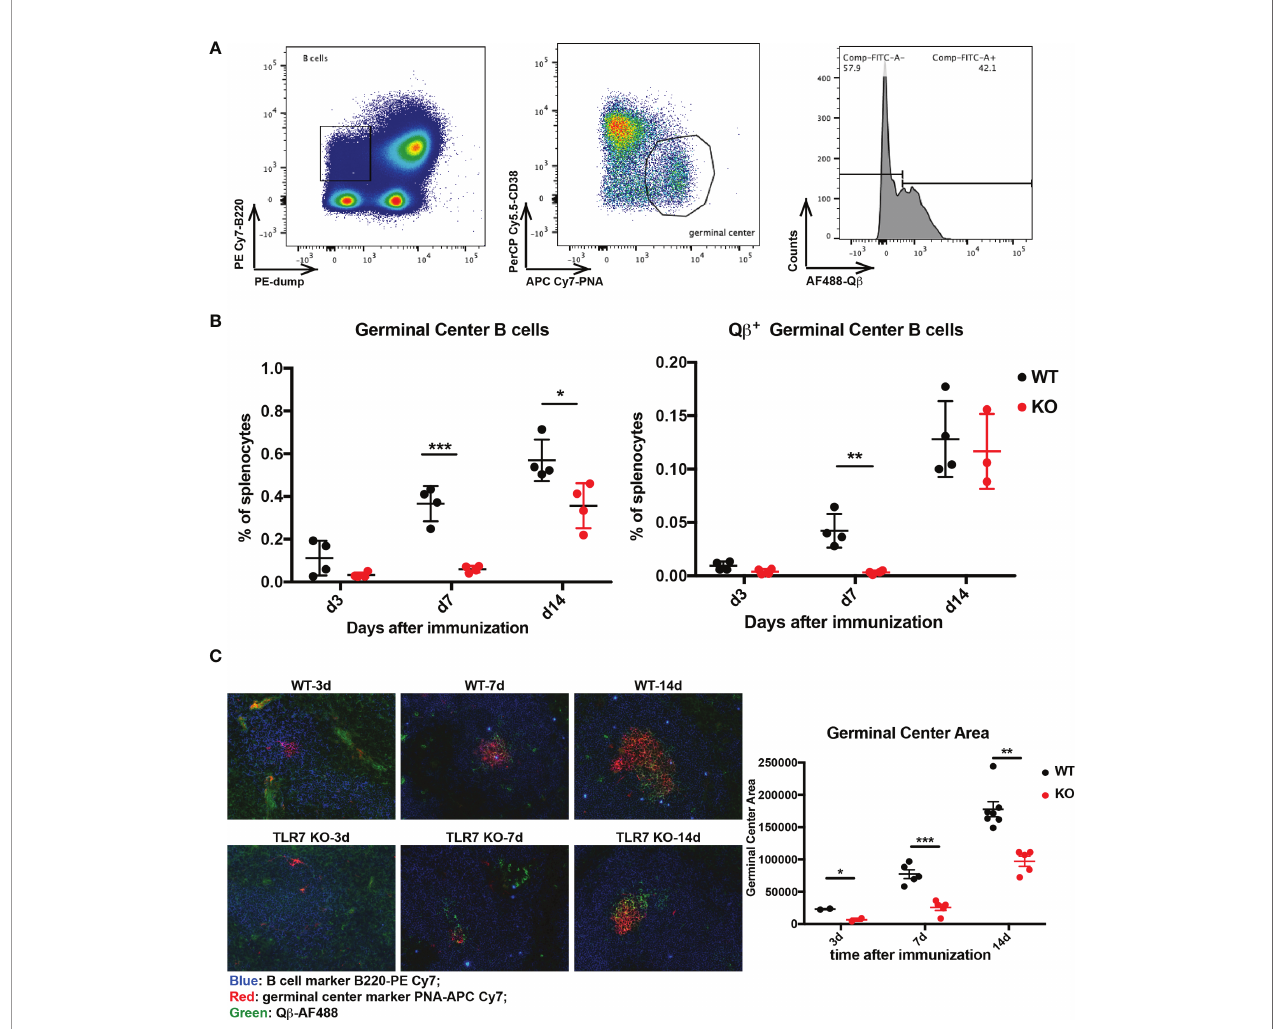
FIGURE 1 | Examination of Q b -speci fi c germinal center reaction. (A) gating strategy to measure germinal center B cells and Q b -speci fi c cells by fl ow cytometry. B cells were de fi ned as B220 high dump (CD4, CD8, IgM, IgD, CD11b, CD11c, GR1) low , from which PNA high CD38 low germinal center cells were selected. Then Q b high cells from germinal center cells were marked. (B) Percentage of germinal center cells (left) and Q b + germinal center B cells (right) in splenocytes were plotted (n = 4). (C) Immuno-histology of Q b -speci fi c germinal centers of spleen sections from WT and TLR7 KO mice during 14 days after Q b immunization. B cells were labeled as B220 (blue), germinal center as PNA (red) and Q b (green). Analysis of germinal center areas with Image J 1.51s. p value from unpaired t-test was indicated as ≤ 0.05 (*), ≤ 0.01 (**), ≤ 0.001 (***). The fi gure is representative of two independent